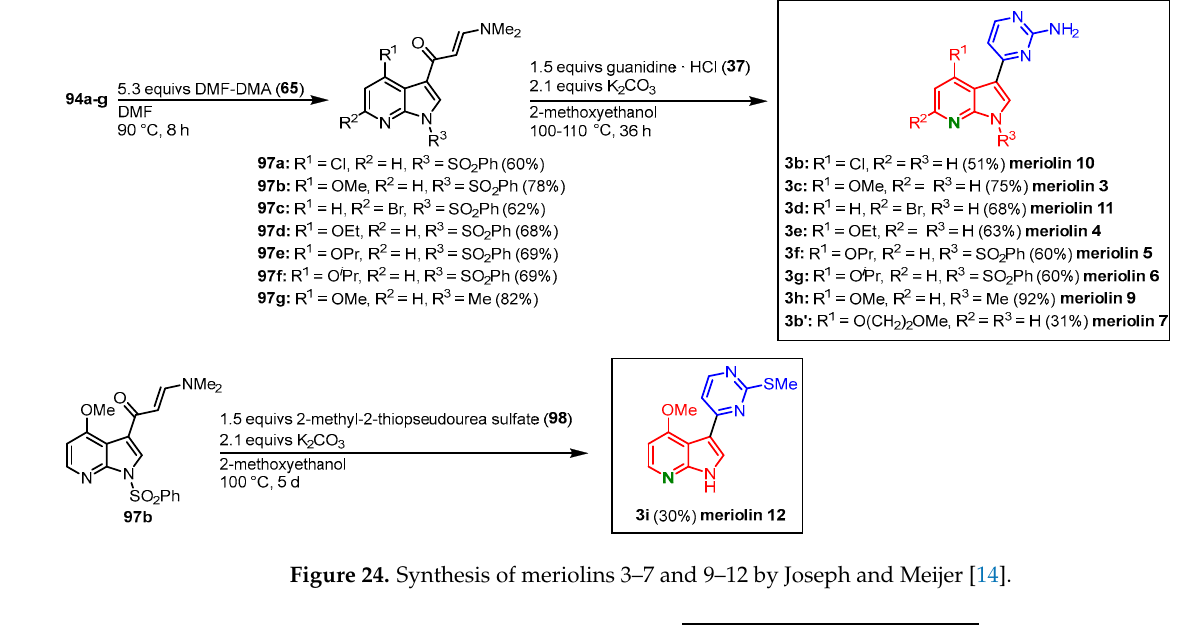
Figure 24. Synthesis of meriolins 3–7 and 9–12 by Joseph and Meijer [14].